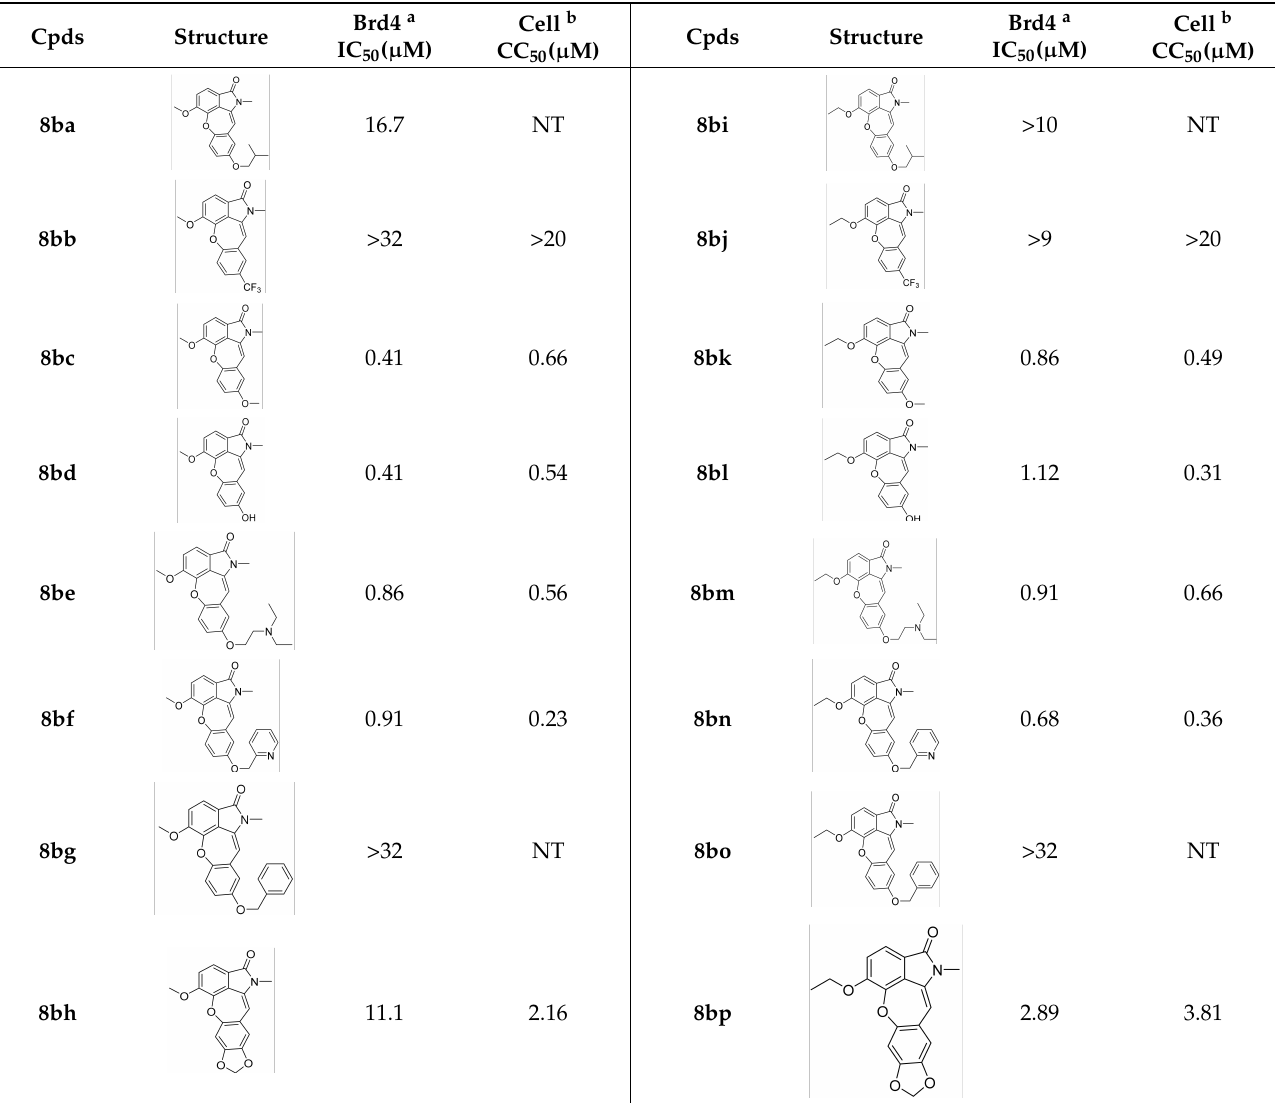
Table 2. Inhibition effects of compounds fixed with hydrogen at R 2 and R 3 position.